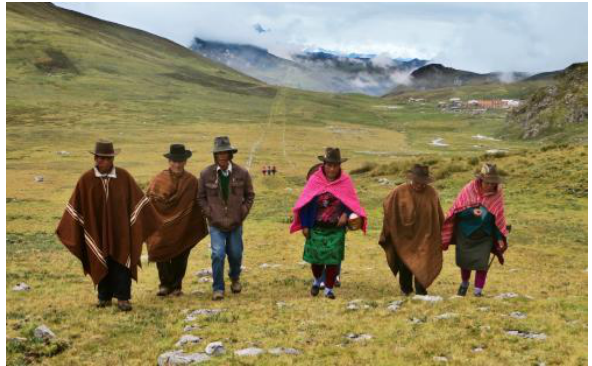
Figure 13. Section Huanuco Pampa - Huamachuco, inhabitants of Huamanin traveled Inca Trail, San Marcos, Huari, Ancash. © Project